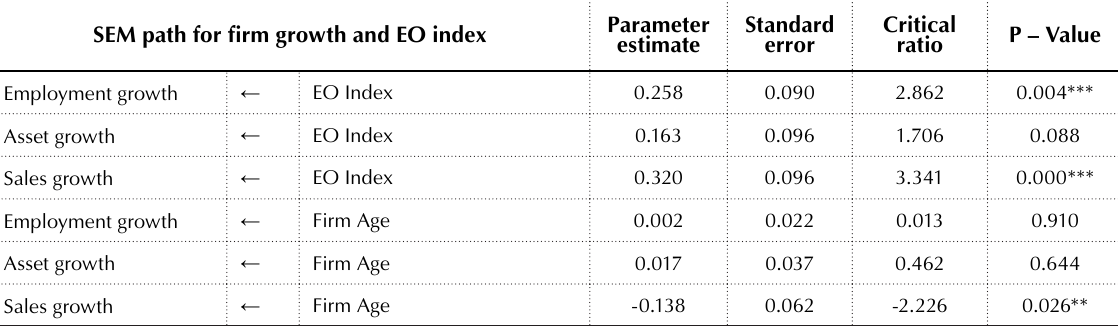
Table 5. SEM associations between firm growth and EO index SEM path for firm growth and EO